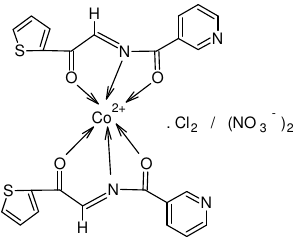
Figure 3. Structure of Complex. Figure 4. Structure of